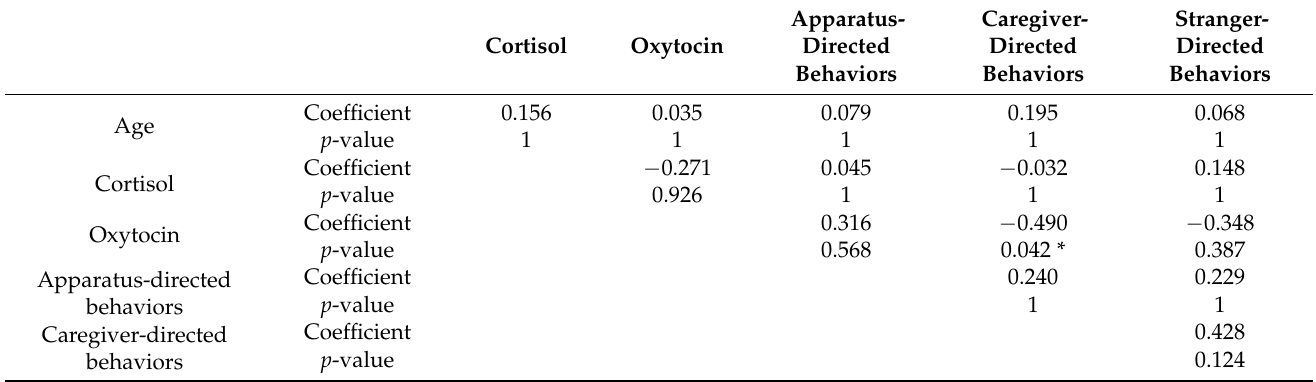
Table 3. Spearman correlations between oxytocin, cortisol, and behavioral variables (latency). Aster- isk indicates a significant correlation. Sample size: 29 cows. * p <